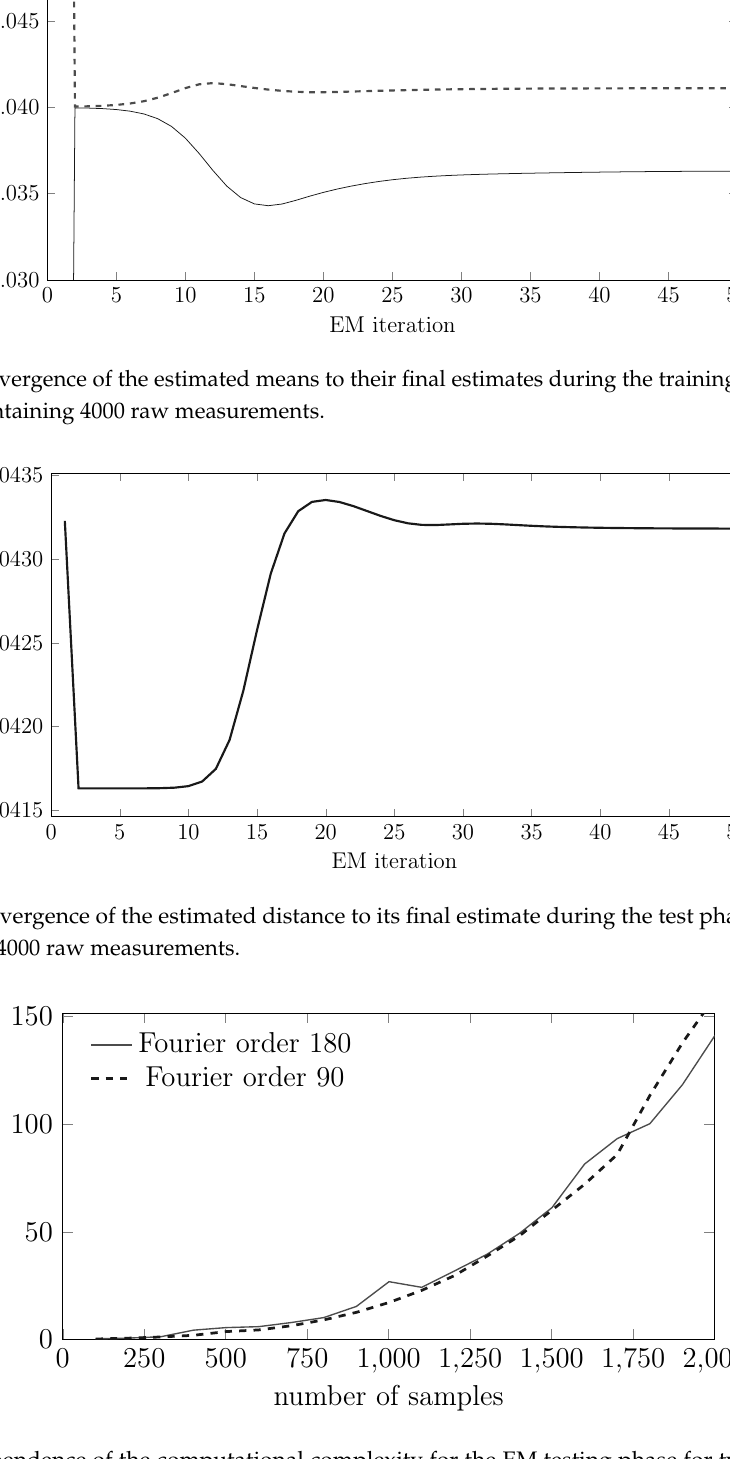
Figure 15. Dependence of the computational complexity for the EM testing phase for two different Fourier order models as a function of the number of samples in the test set.